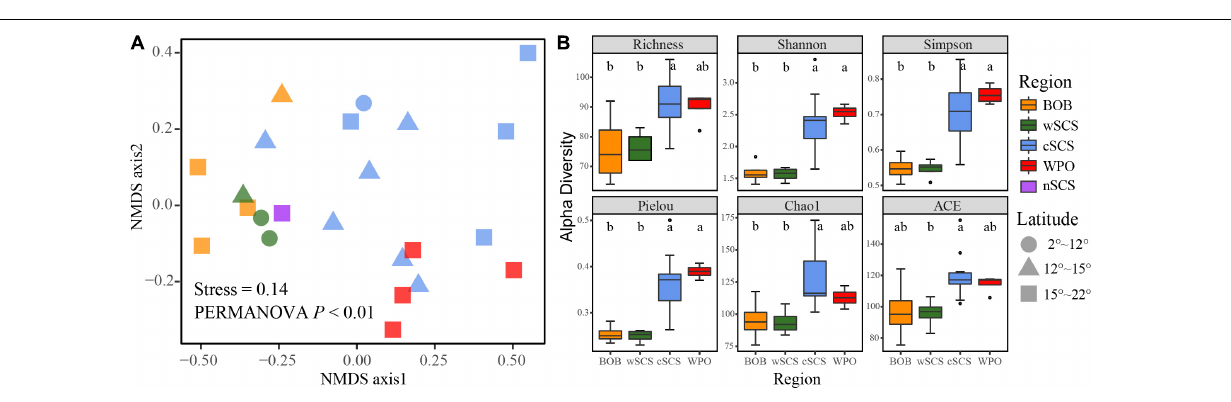
FIGURE 2 | Spatial heterogeneity of UCYN-A communities in three contrasting seas. (A) Non-metric multidimensional scaling (NMDS) analysis revealed the spatial variation of UCYN-A. Significant difference was determined by PERMANOVA with 9,999 permutations. (B) The alpha diversity indices across different regions. Boxplots that do not share a letter are significantly different ( p < 0.05; non-parametric Wilcoxon rank-sum